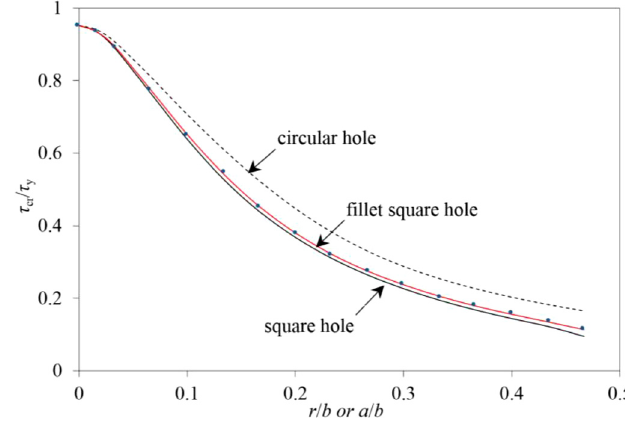
Fig. 9. The in fl uence of hole ’ s shape on critical stress ( t =